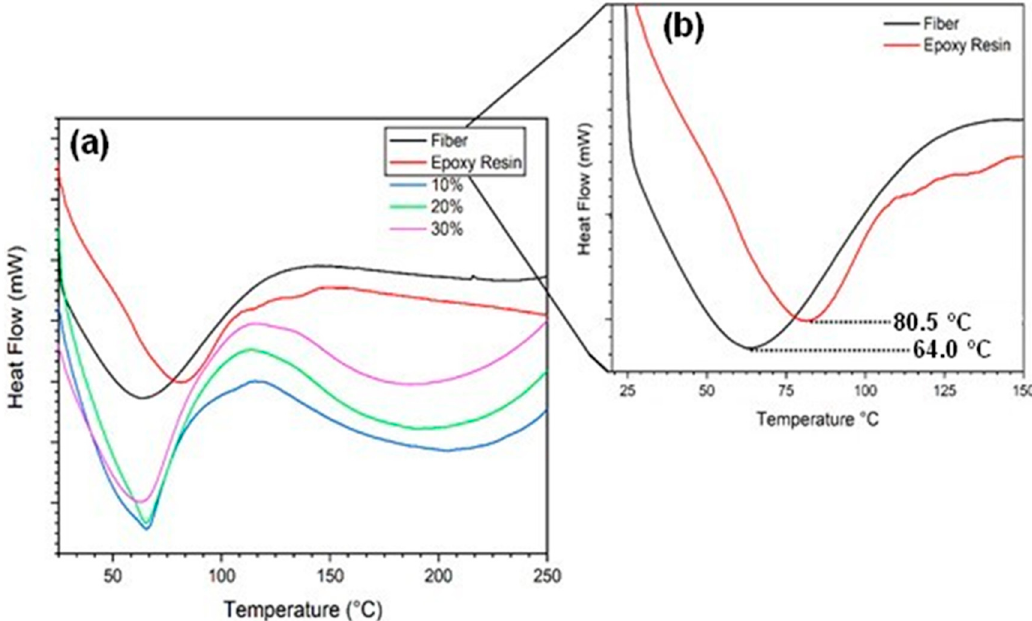
Figure 12. Differential scanning calorimetry (DSC) curves of ( a ) caranan fiber, epoxy resin and their composites ( b ) magnified endothermic peaks for the caranan fiber and neat epoxy. Table 5. Glass transition temperature (T g ) for di ff erent material